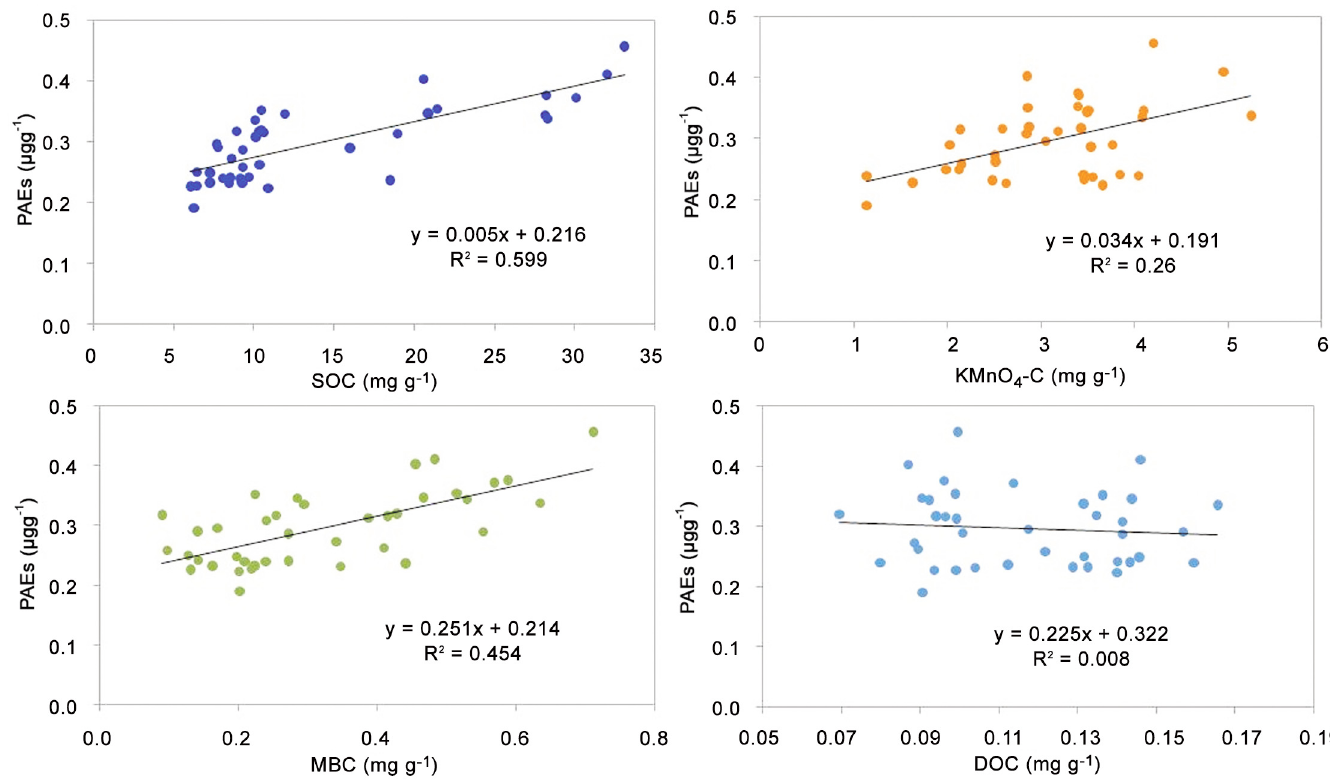
Fig 3. Correlations of PAEs concentrations with the soil organic carbon fractions in the agricultural soils along the WYR. SOC, soil organic carbon; KMnO 4 -C, permanganate oxidizable carbon; MBC, microbial biomass carbon; DOC, dissolved organic carbon.